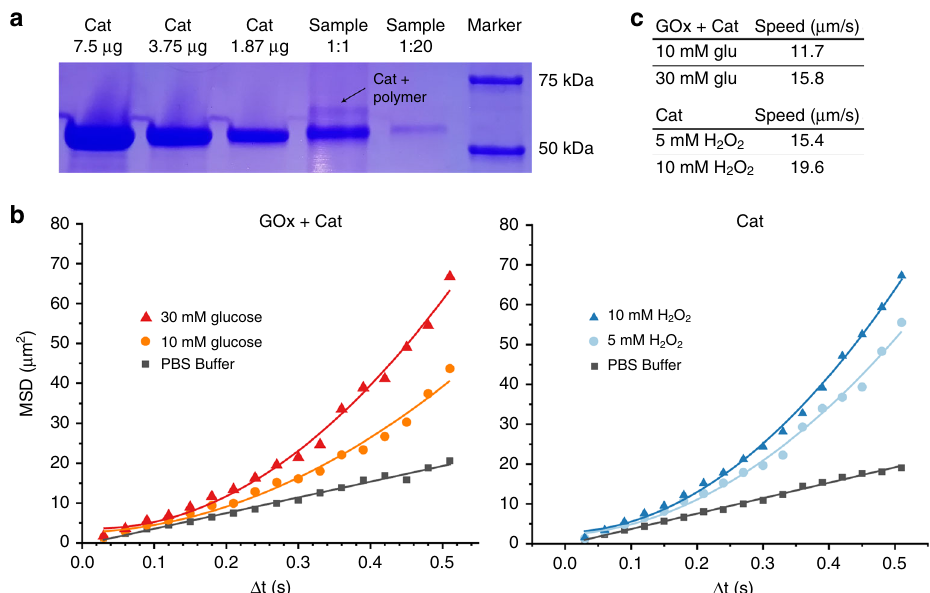
Fig. 3 Characterization of PEG-PDLLA nanomotors. a SDS-PAGE demonstrating successful coupling of catalase to the polymer, indicated by black arrow. b Mean-squared displacement (MSD) values of stomatocytes obtained with various fuel concentrations, 30 mM glucose (red triangles), 10 mM glucose (orange circles), PBS buffer (gray squares), 10 mM H 2 O 2 (darker blue triangles), 5 mM H 2 O 2 (lighter blue circles). c Overview of movement speeds of the nanomotors at various fuel concentrations for both enzyme